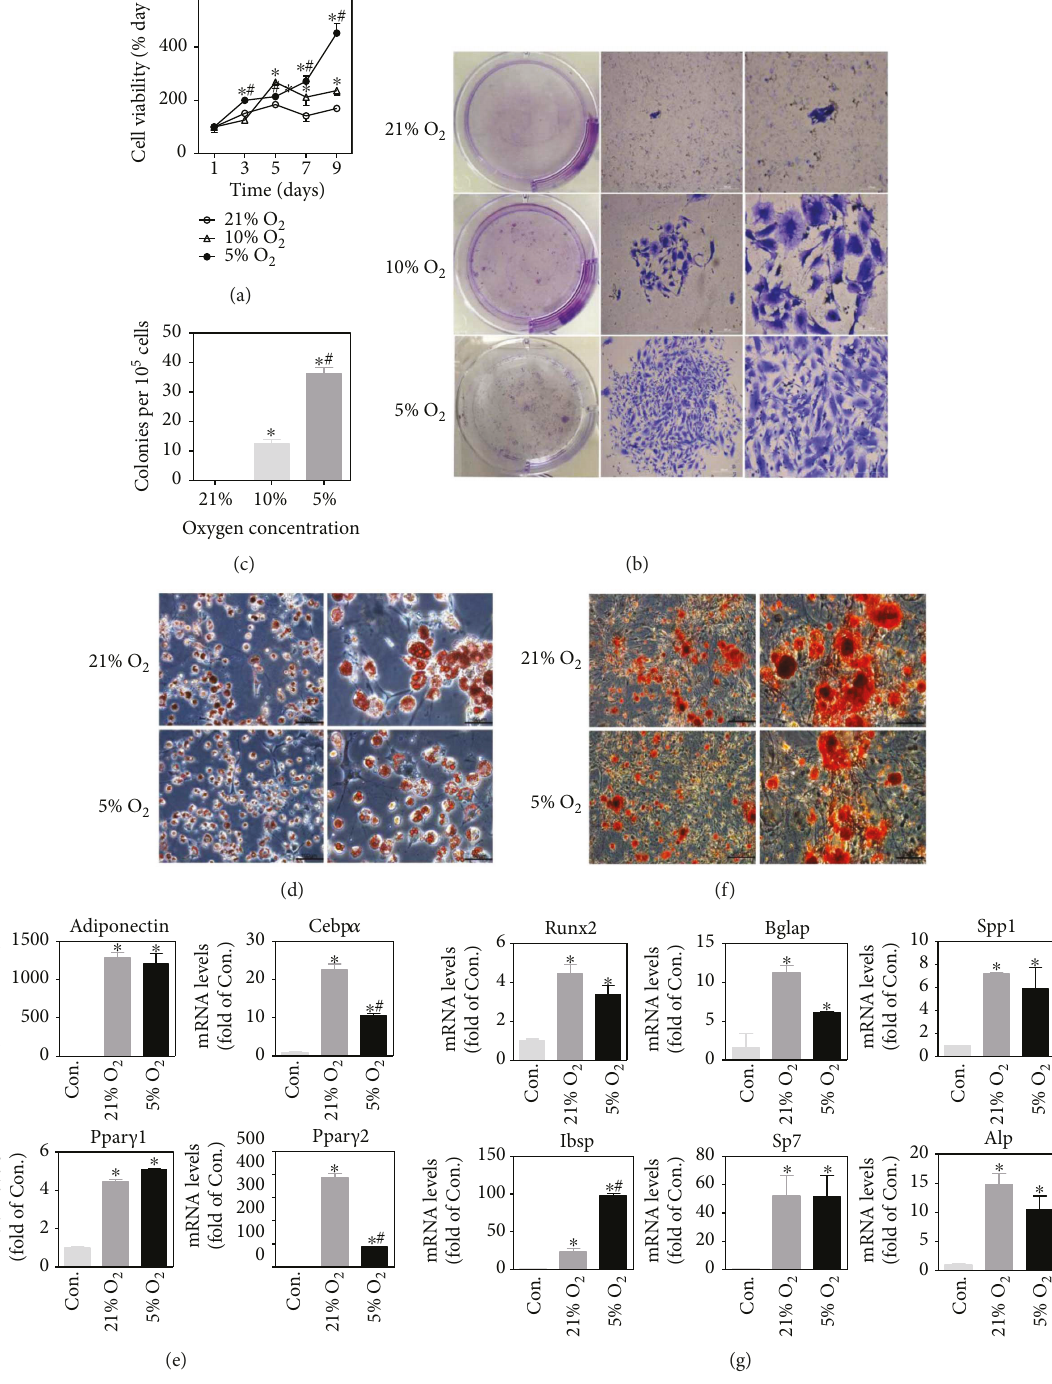
Figure 2: The e ff ects of oxygen concentration on proliferation capacity and di ff erentiation potential of BM-MSCs. (a) Comparison of cell viability in di ff erent oxygen concentrations as determined by CCK8. (b) Representative images for colonies in each group in CFU assay (from left to right, the view from one well of the six-well plate, × 40 with scale bar =500 μ m, and × 100 with scale bar =200 μ m). (c) Quanti fi cation of CFU assay. Colonies with an area above 1 mm 2 were counted. (d) Representative images for Oil Red O staining in 21% and 5% oxygen conditions (from left to right, × 200 with scale bar =100 μ m, × 400 with scale bar =50 μ m). (e) The expression of adipogenic di ff erentiation-related genes of BM-MSCs after di ff erentiation induction in 21% and 5% oxygen conditions. (f) Representative images for Alizarin Red S staining in 21% and 5% oxygen conditions (from left to right, × 100 with scale bar =200 μ m, × 200 with scale bar =100 μ m). (g) The expression of osteogenetic di ff erentiation-related genes of BM-MSCs after di ff erentiation induction in 21% and 5% oxygen conditions. P15 and P11 BM-MSCs were used for adipogenic and osteogenic di ff erentiation, respectively. Results are expressed as mean ± SD from three independent measurements. ∗ p < 0 05 versus Con. group; # p < 0 05 versus 21%